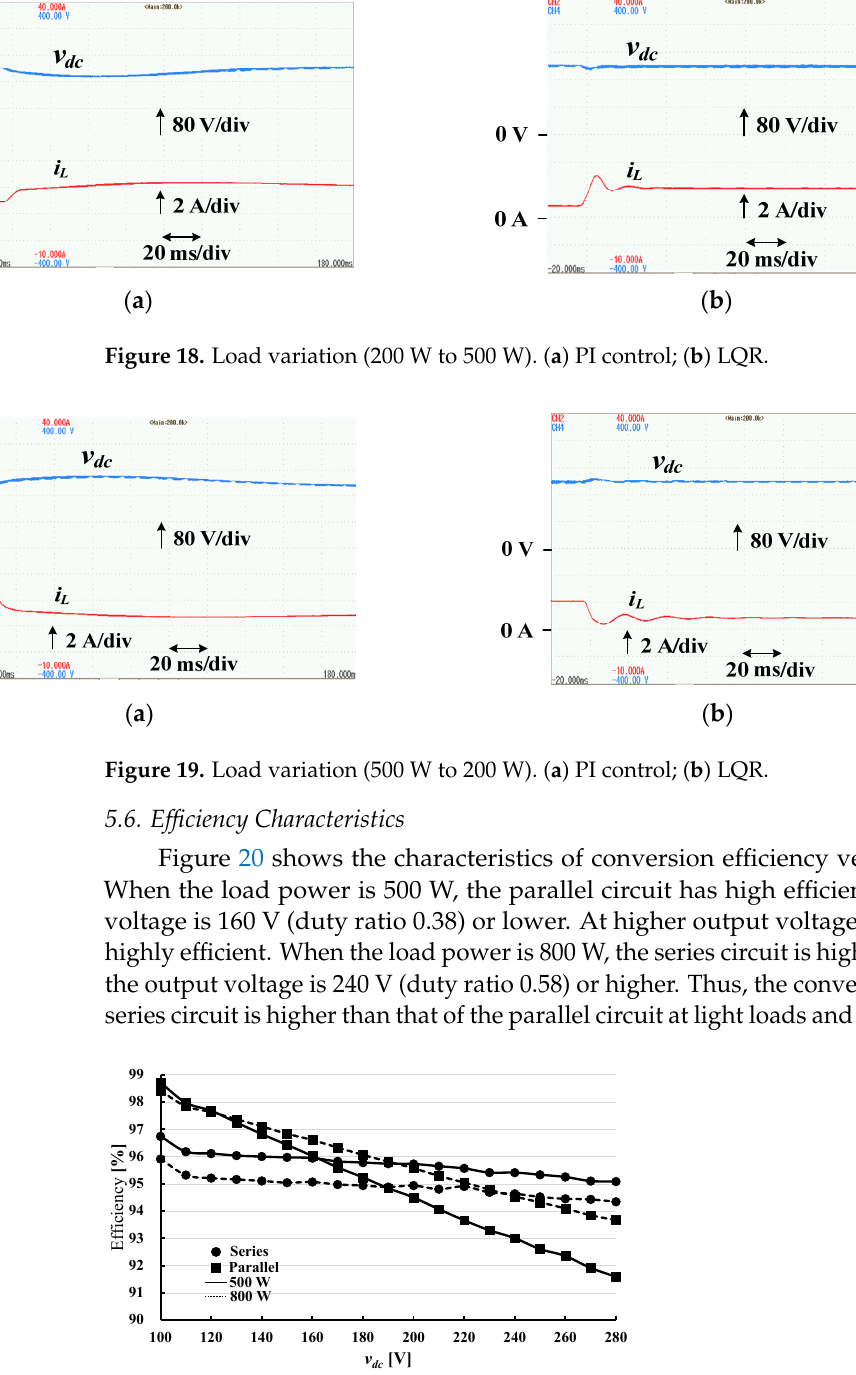
Figure 21. Efficiency characteristics for output power. Figure 22. Loss comparison of parallel circuit when output voltage is 280 V.